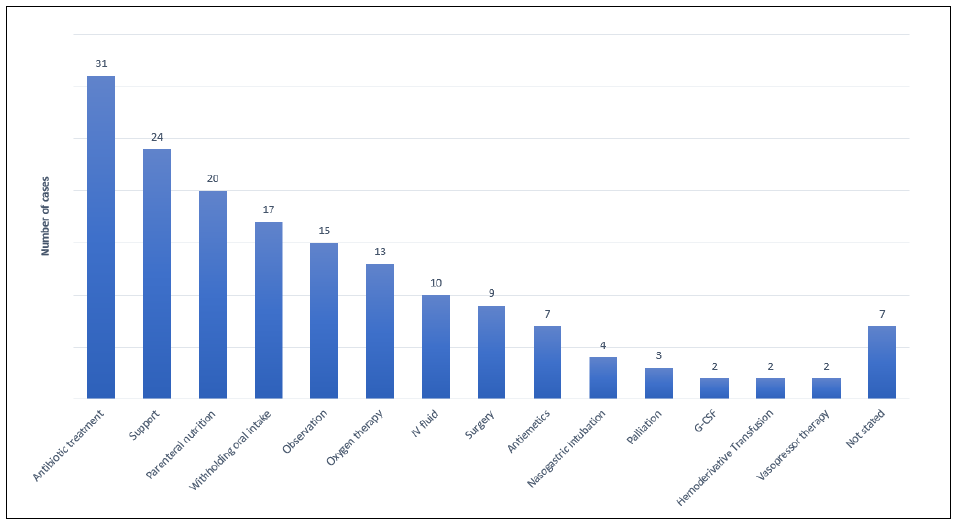
Figure 4. Time (in weeks) from treatment start to PI onset.